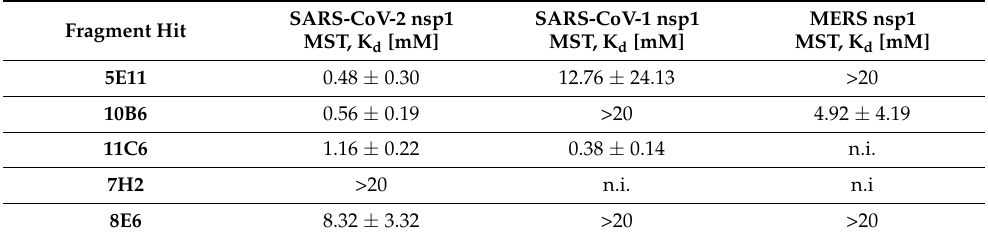
Table 4. Cross-binding effects of fragment hits identified against SARS-CoV-2 nsp1 10-126 and their estimated binding effects on the nsp1 homologues from SARS-CoV-1 and MERS. n.i, no